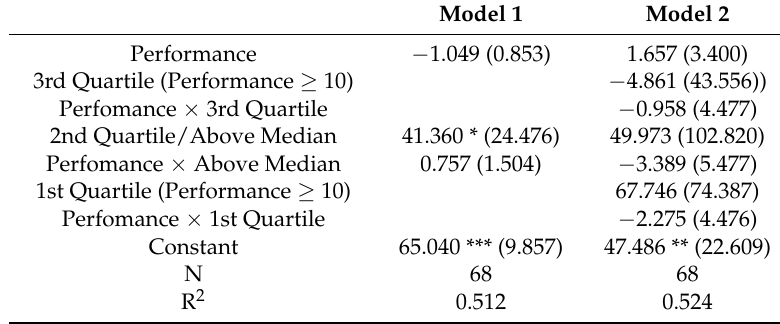
Table 5. OLS Estimation on the impact of task performance on minimum claims of high and low contributors in the Equal Opportunities